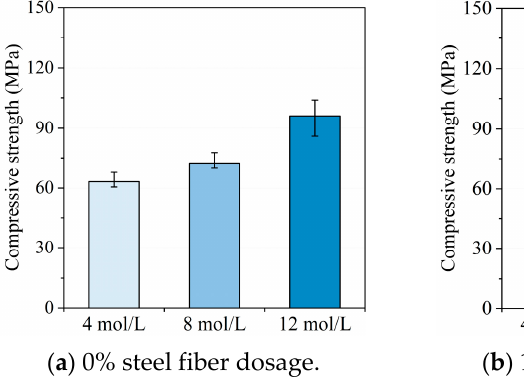
Figure 6. The influence of NaOH solution concentration on compressive strength.